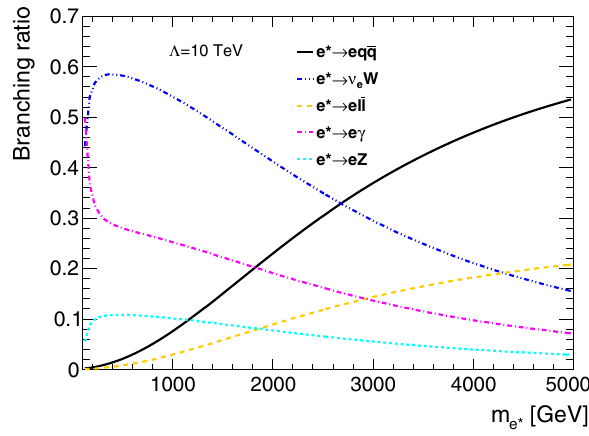
Fig. 1 Branching ratios for excited electrons as a function of m e ∗ . The scale (cid:4) is set to 10